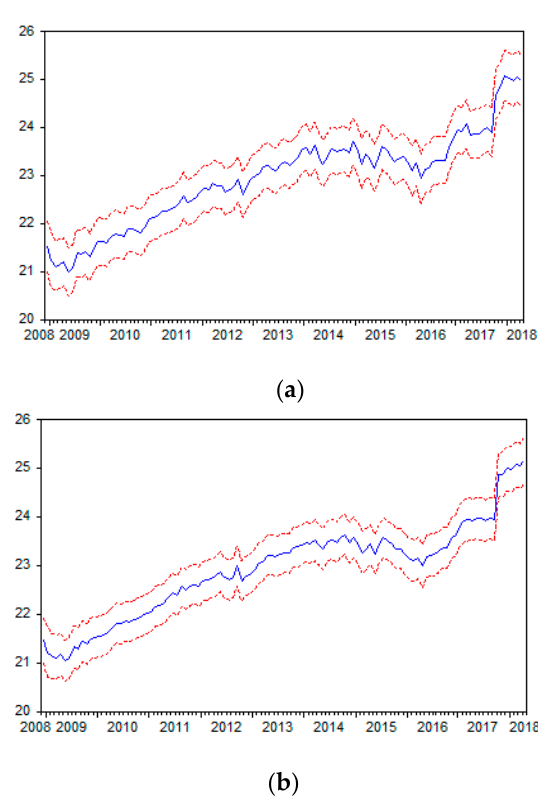
( ± 2 standard errors). SA